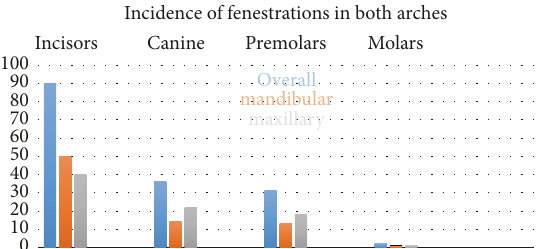
Figure 3: Incidence of fenestrations by tooth type.